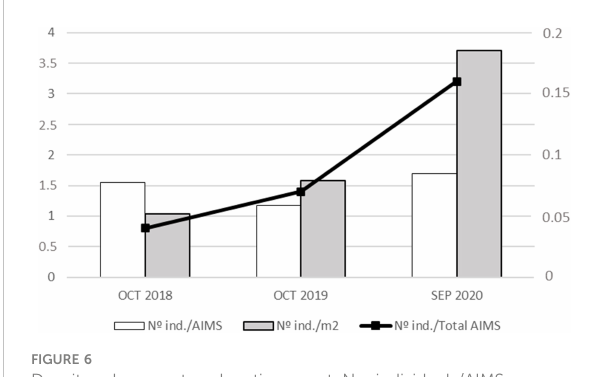
FIGURE 6 Density values per translocation event. No. individuals/AIMS: mean number of individuals per each of the translocated AIMS. No. ind./ m 2 : mean number of individuals per square meter, considering the whole set of deployed AIMS, which were the available surface for settlement (660 AIMS = 29.7 m 2 ). No. ind./Total AIMS: mean number of individuals settled considering the whole set of deployed AIMS (660). No. ind./AIMS and No. ind./m 2 are represented by the left Y axis, whereas No. ind./Total AIMS is represented by the right Y